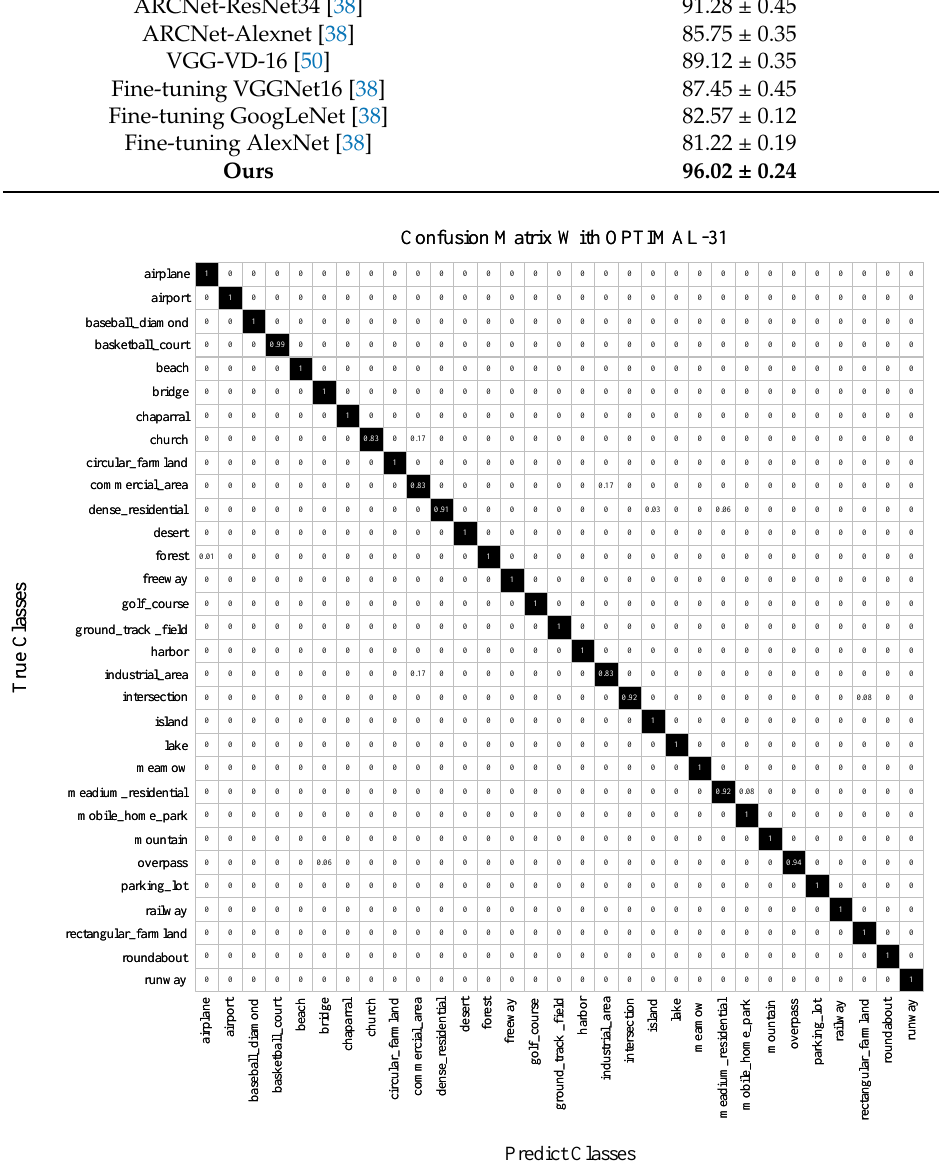
Figure 11. CM on OPTIMAL-31 under the training ratio of